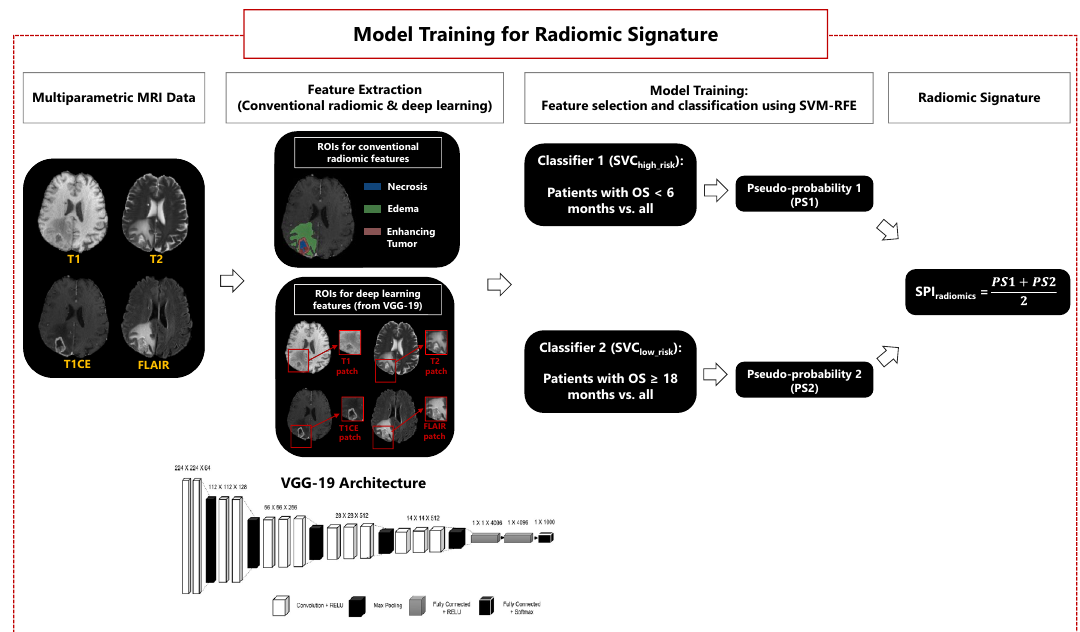
Figure 2. An illustration of model training process for predicting the radiomic signature of overall survival (OS). After preprocessing of multiparametric MRI scans, conventional radiomic features are extracted from the segmented tumorous subregions, i.e., necrosis (NC), edema (ED), and enhancing tumor (ET). Deep learning features are derived from the whole tumor region (union of NC, ED, and ET subregions) using VGG-19 network architecture. Two binary classifiers are built: SVC high_risk to discriminate the short survivor patients from other patients, and SVC low_risk to differentiate the long survivor patients from the rest of the patients. The output of each classifier, i.e., pseudo-probability1 or pseudo-probability2, are combined to generate SPI radiomics , which represents the radiomic signature of OS for the